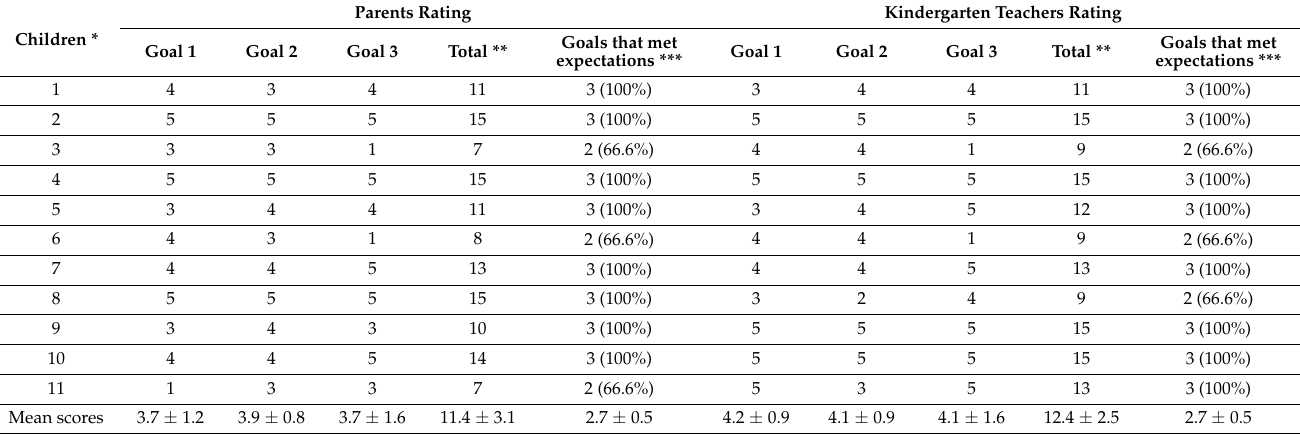
Table 2. Post-intervention (T2) results of the Goal Attainment Scale, rated by parents